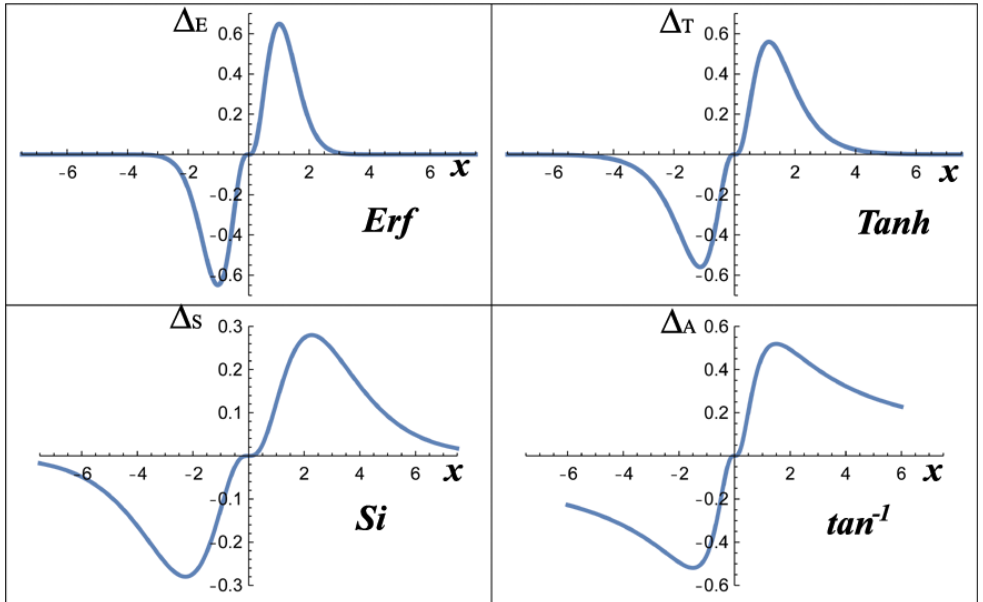
Fig. 2 The difference ∆ between the normalized numerical Br/Lr and the curves of the equivalent functions shown in Fig. 1.